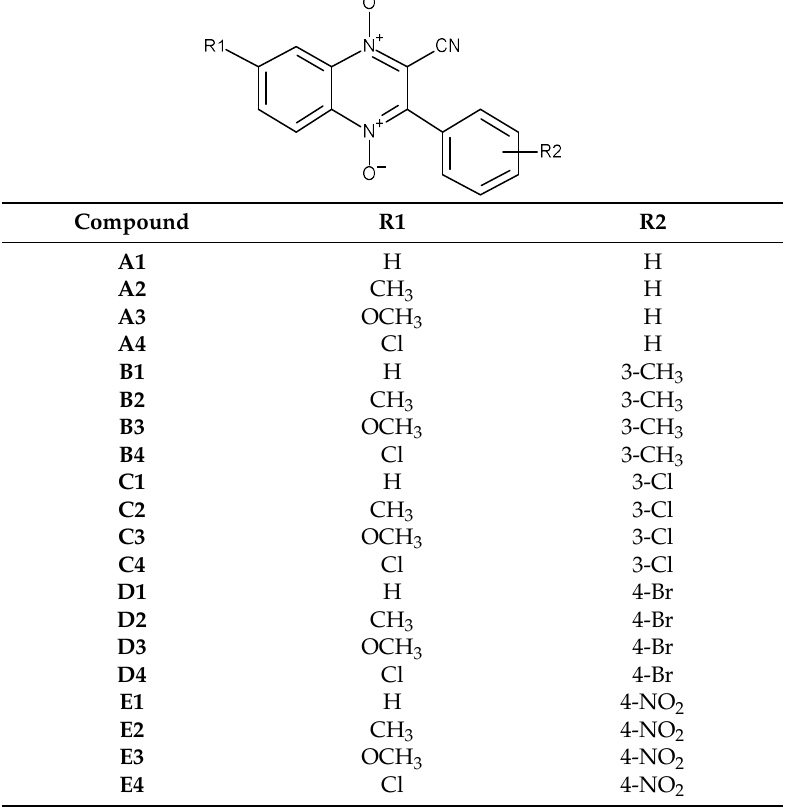
Table 1. Structures of the 3-aryl-quinoxaline-2-carbonitrile 1,4-di-N-oxide derivatives [26,27].